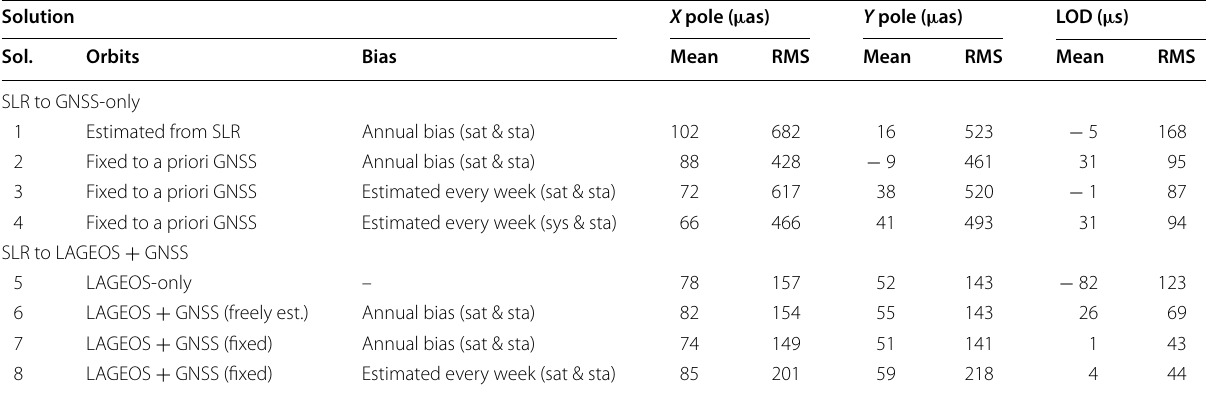
Table 2 Comparison of estimated ERPs to the IERS-14-C04 series Solution X pole ( µ as) Y pole ( µ as) Sol.